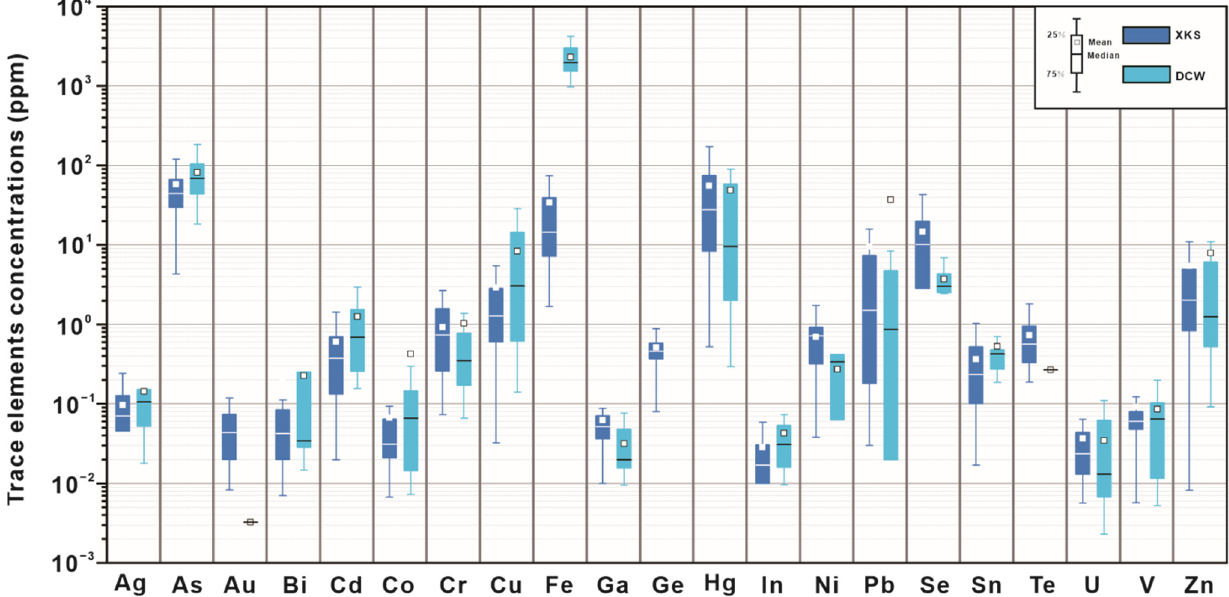
Figure 9. Trace element data for the stibnite measured by LA-ICP-MS from the Xikuangshan and Daocaowan Sb deposits. All values are in ppm.